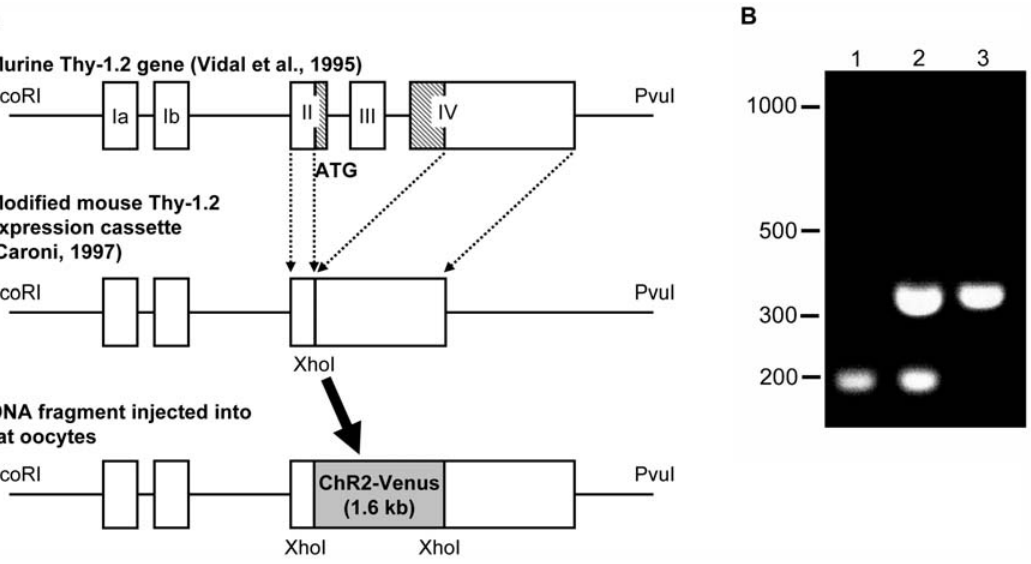
Figure 1. Generation of Thy-1.2 ChR2V transgenic rat. Schematic drawing of DNA fragment injected into rat oocytes. (A) The cDNA coding channelrhodopsin-2 (ChR2) tagged with Venus was inserted at XhoI site of the modified mouse Thy-1.2 expression cassette. A linearized DNA fragment (7.5 kb) prepared by digestion with EcoRI and PvuI restriction enzymes was injected into rat oocytes. (B) Examples of PCR analysis of genomic DNA from transgenic founder rats injected with the transgene shown in A. Genomic DNAs from the injected DNA fragment (lane 1), a transgenic founder (lane 2) and a non transgenic founder (lane 3) were amplified by PCR. DNA bands at 173 bp and 324 bp correspond to amplified DNA fragments for the transgene (ChR2-Venus, ChR2V) and the T cell receptor gene as an internal control,